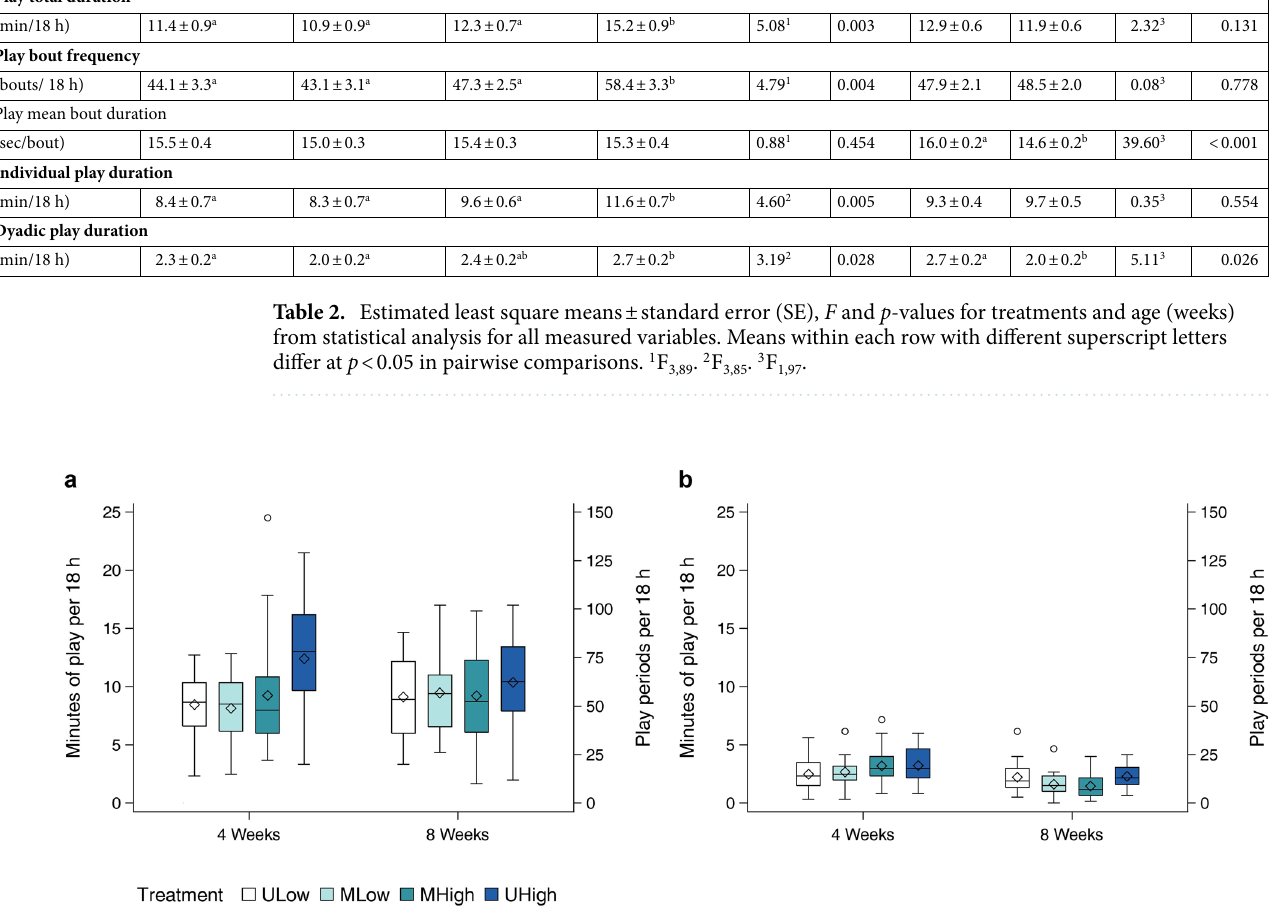
Figure 3. Duration of individual play ( a ) and dyadic play ( b ) by treatment and age. Diamonds represent arithmetic